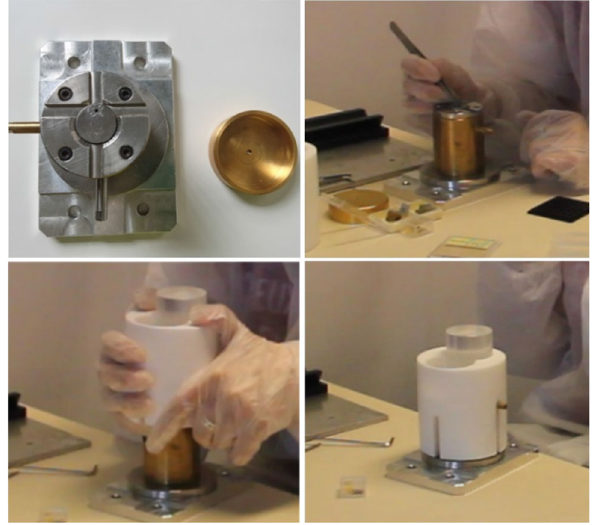
Fig. 2 The tool for gluing the sensor (top left) together with the cap to provide a 50 µ m gap. The process of gluing is shown in the three other photos: NTD placement (top right) and placement of the crystal (bottom